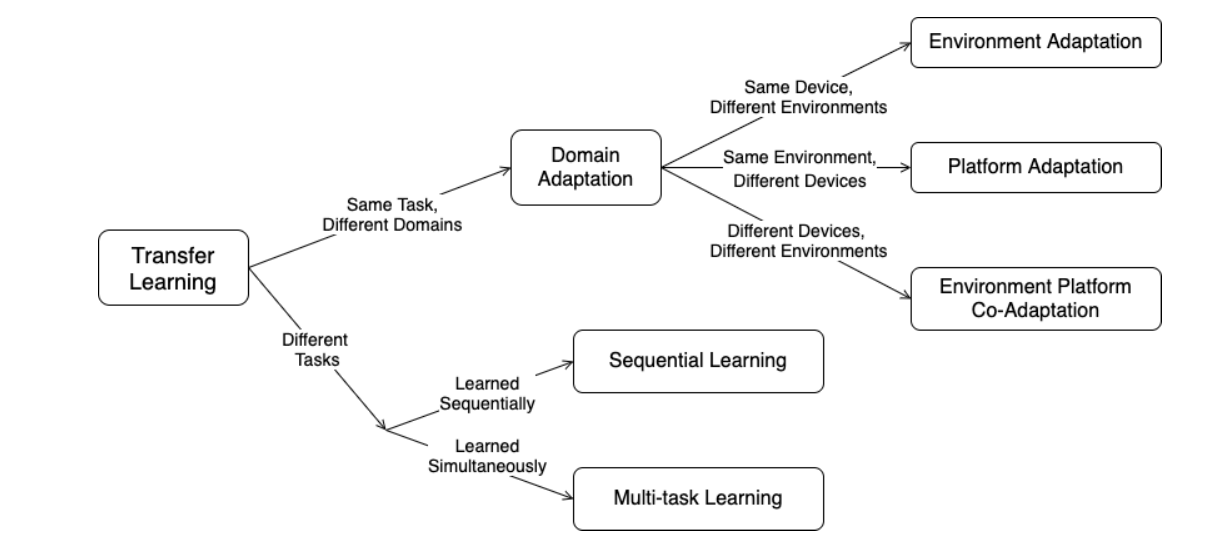
Figure 3. The proposed TL taxonomy for RFML. Table 3. Representative examples for TL settings in